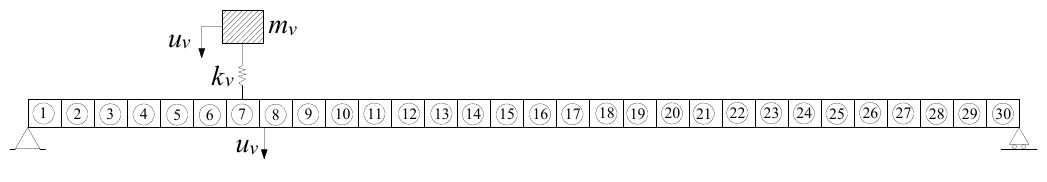
Figure 3. Single ‐ DOF sprung mass moving along a simply supported bridge beam model. Figure 3. Single-DOF sprung mass moving along a simply supported bridge beam Table 1. Essential parameters of the vehicle–bridge system.